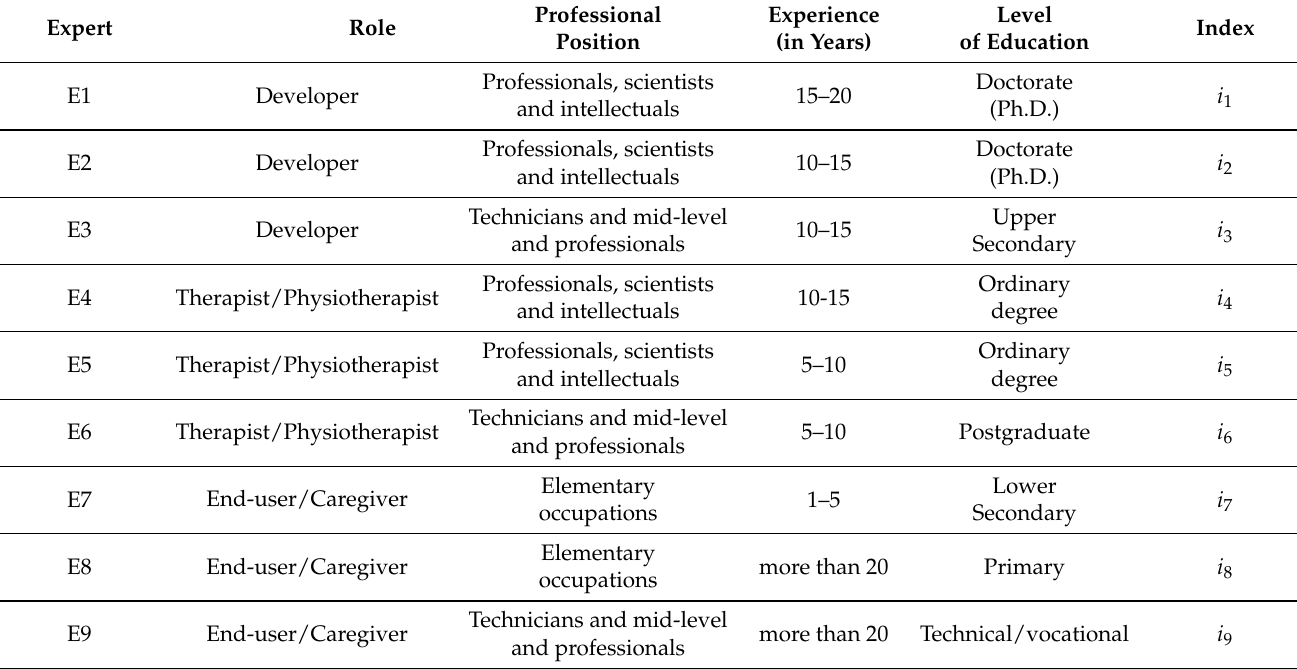
Table 8. Information used for